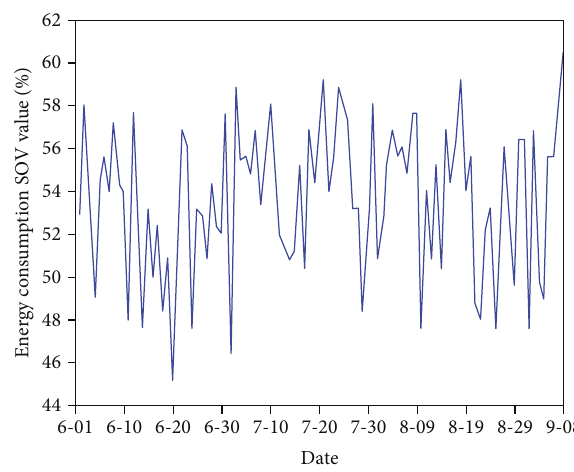
Figure 1: Consumption of SOC value curve for 100 consecutive